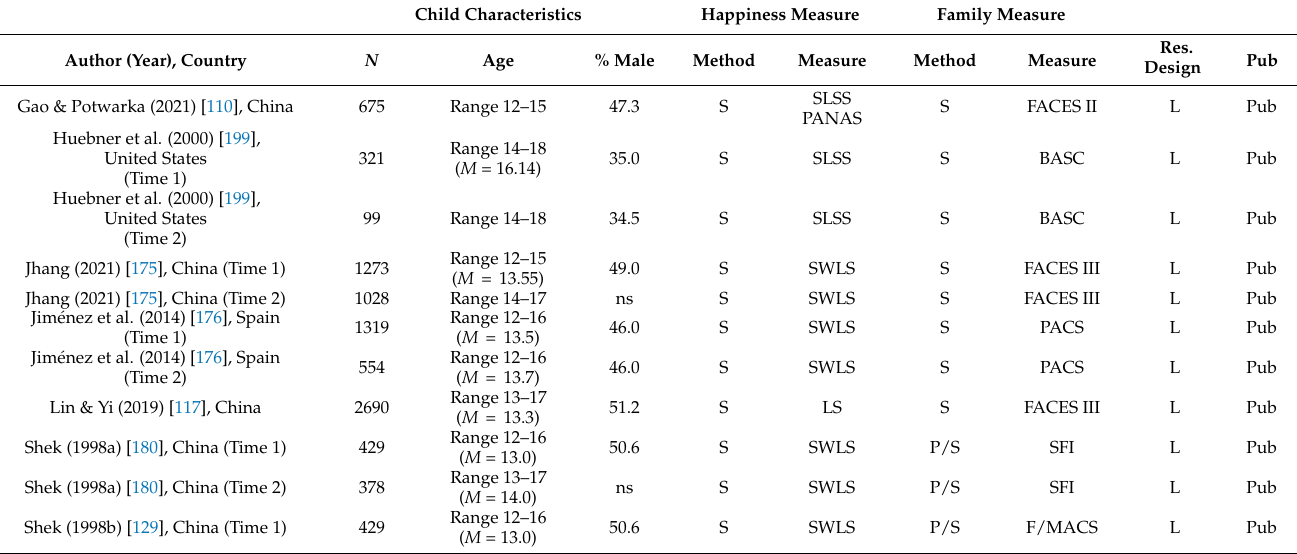
Table 4. Sample Characteristics and Methods of Assessment of the Longitudinal Studies ( n =